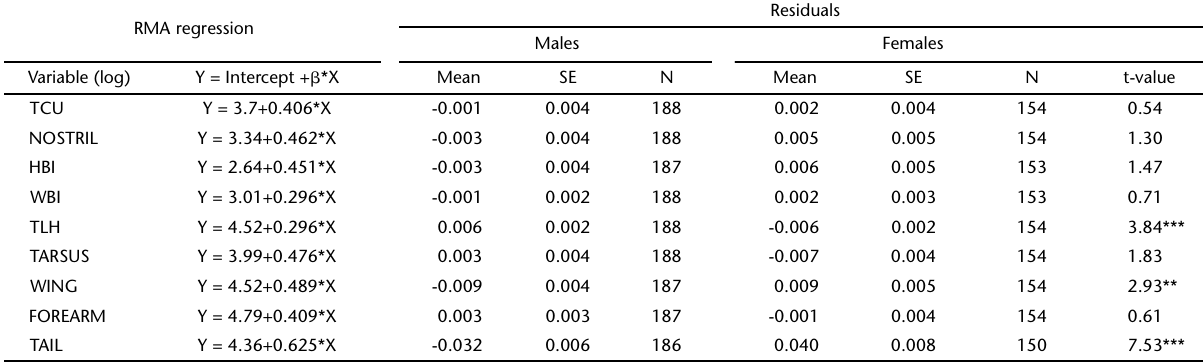
Table III. Differences in elevation between sexes of mature Coscoroba Swan for Reduced Major Axis (RMA) regression of morphometric measurement against body mass (log